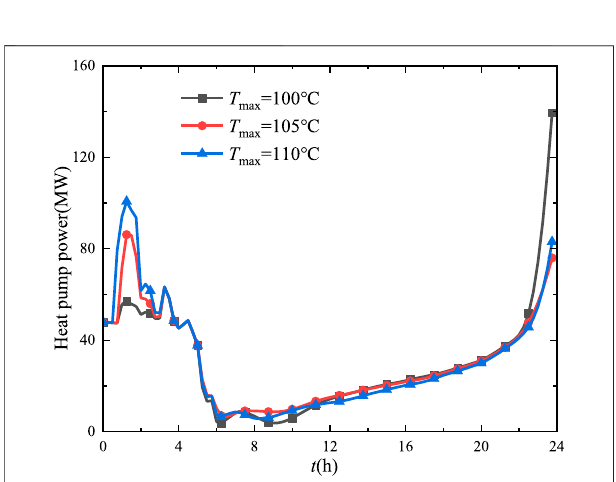
FIGURE 16 | Variations of heat pump power under different maximum